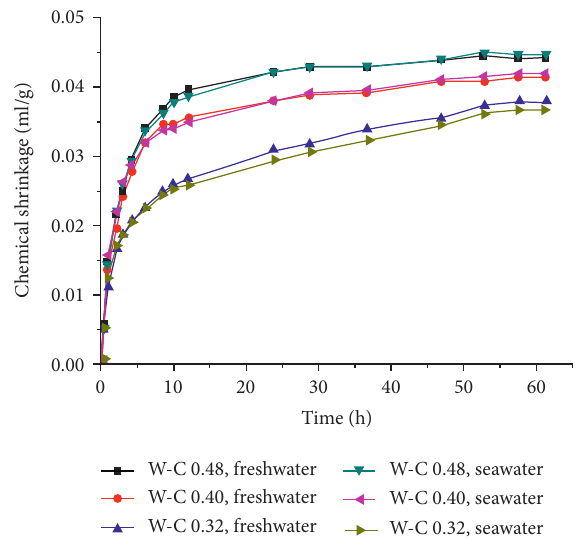
Figure 6: Influence of w/c ratio and mixing water on chemical shrinkage of CSA